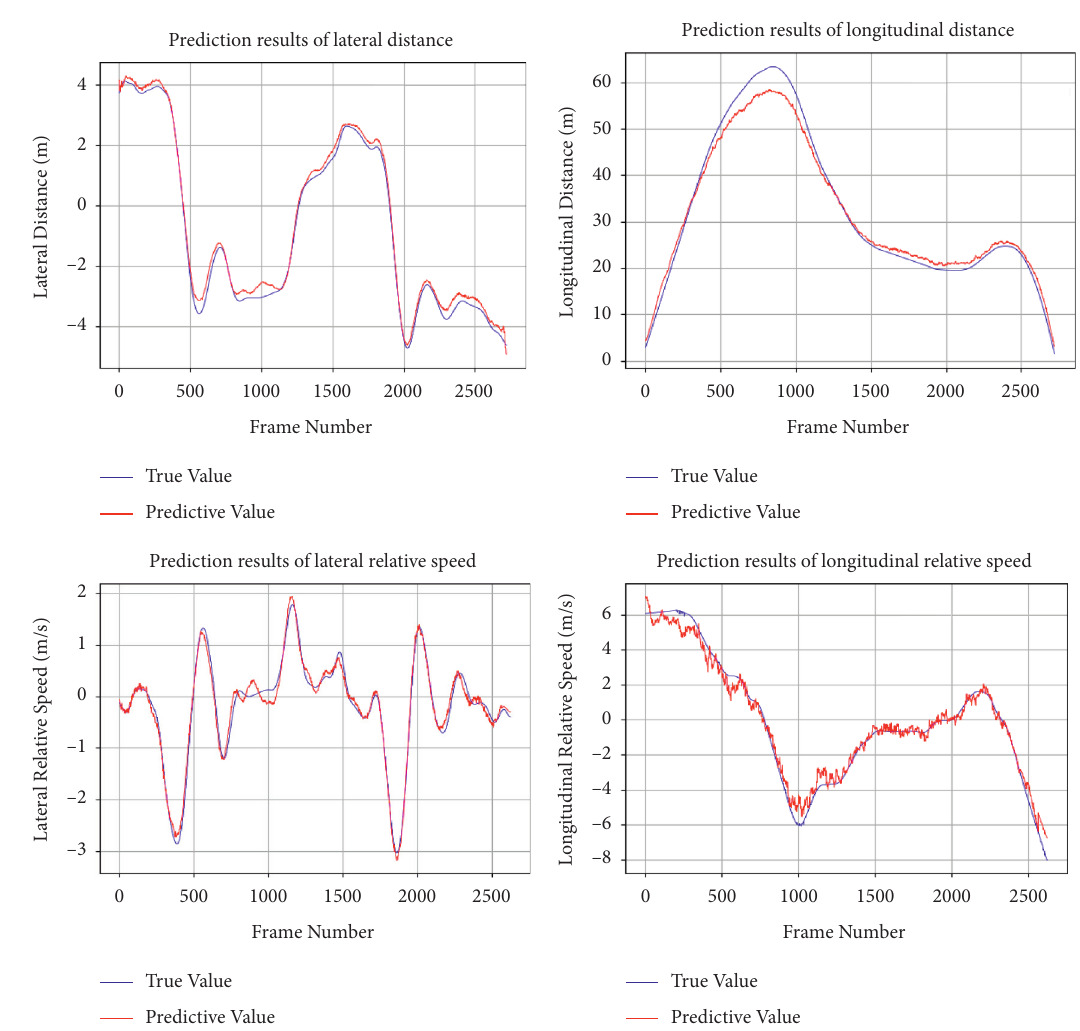
Figure 12: Estimation results of simulation driving experiment. Prediction result of (a) lateral distance, (b) longitudinal distance, (c) lateral relative speed, and (d) longitudinal relative speed.